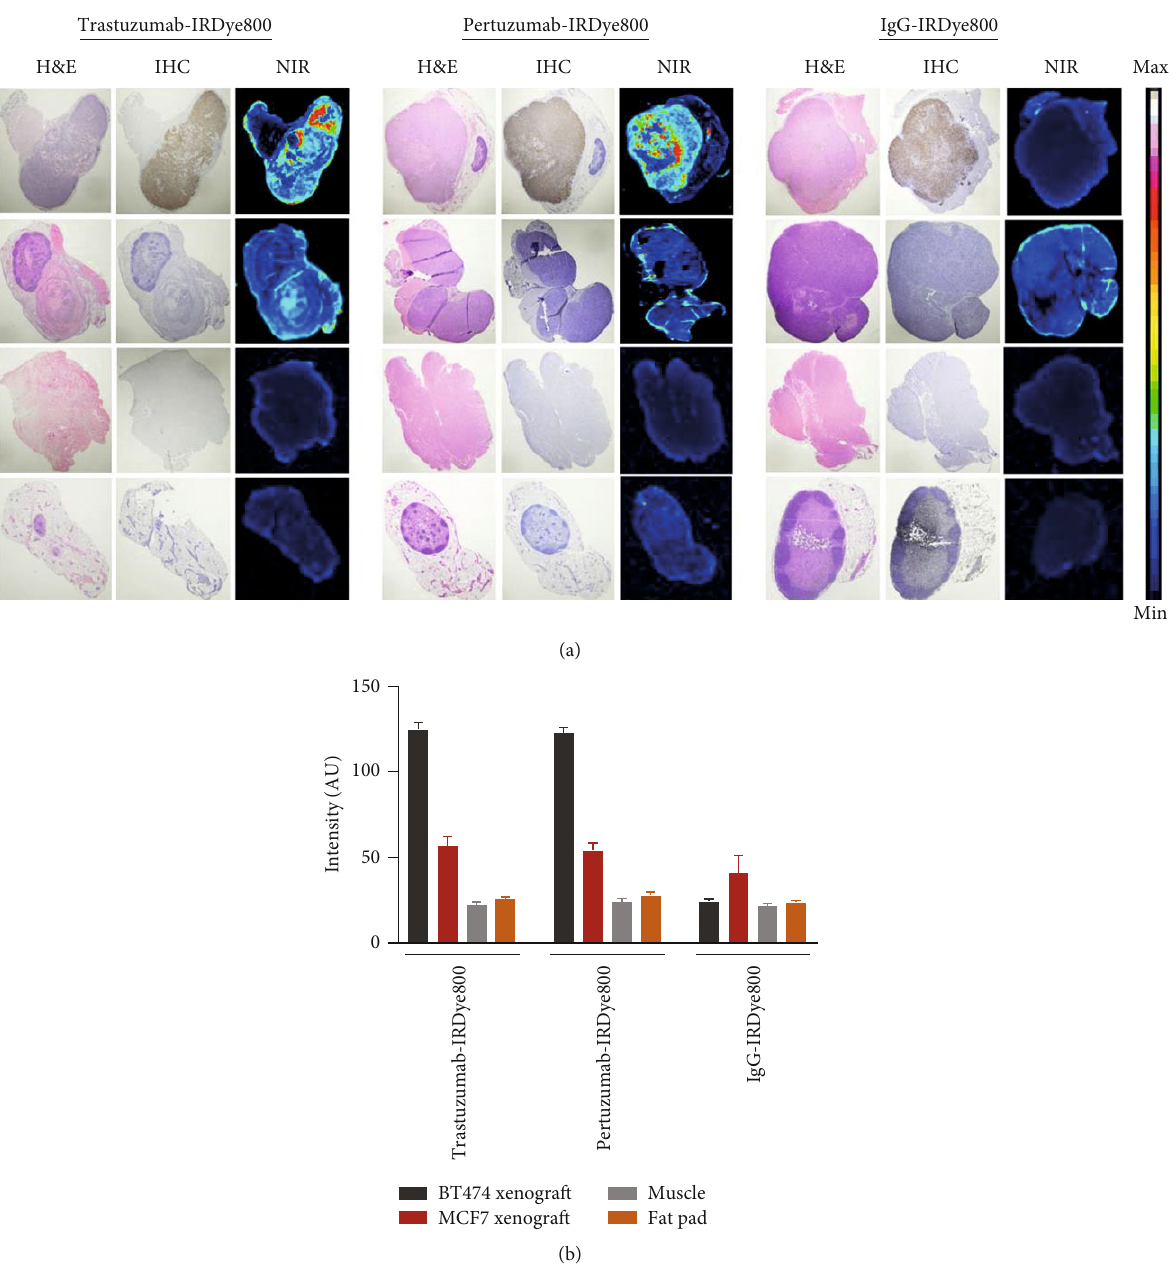
Figure 5: Histological analysis of immunoconjugate uptake. NIR fl uorescence from IRDye800-labeled trastuzumab and pertuzumab correlated with IHC (a). Quantitative analysis of the fl uorescence signal was higher in BT474 tumors compared to MCF7 tumors and normal tissues